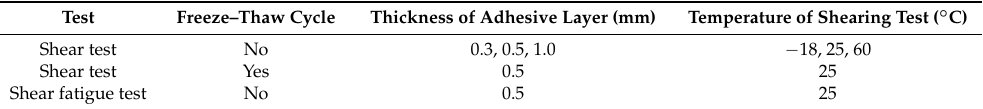
Table 3. Test matrix of composite